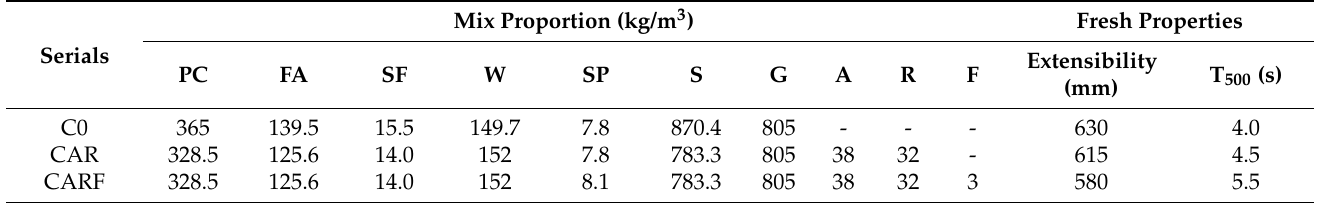
Table 2. Mix proportions and fresh properties of